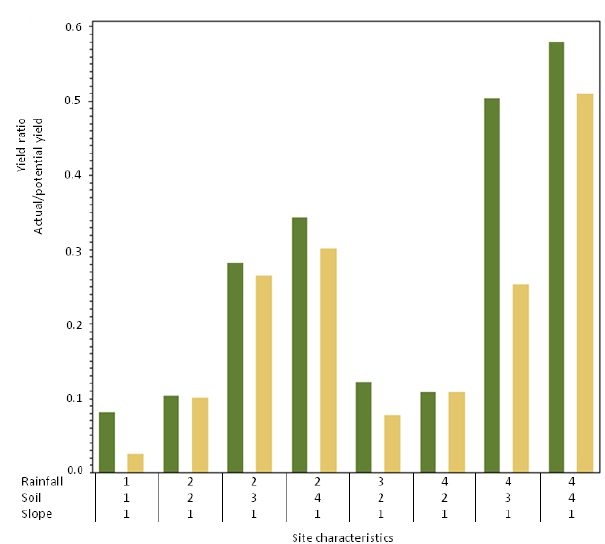
Figure 4. Percentage area coverage (green bar) and available com- binations for pairwise uniform sites (red bar) defined by number of selected variables.